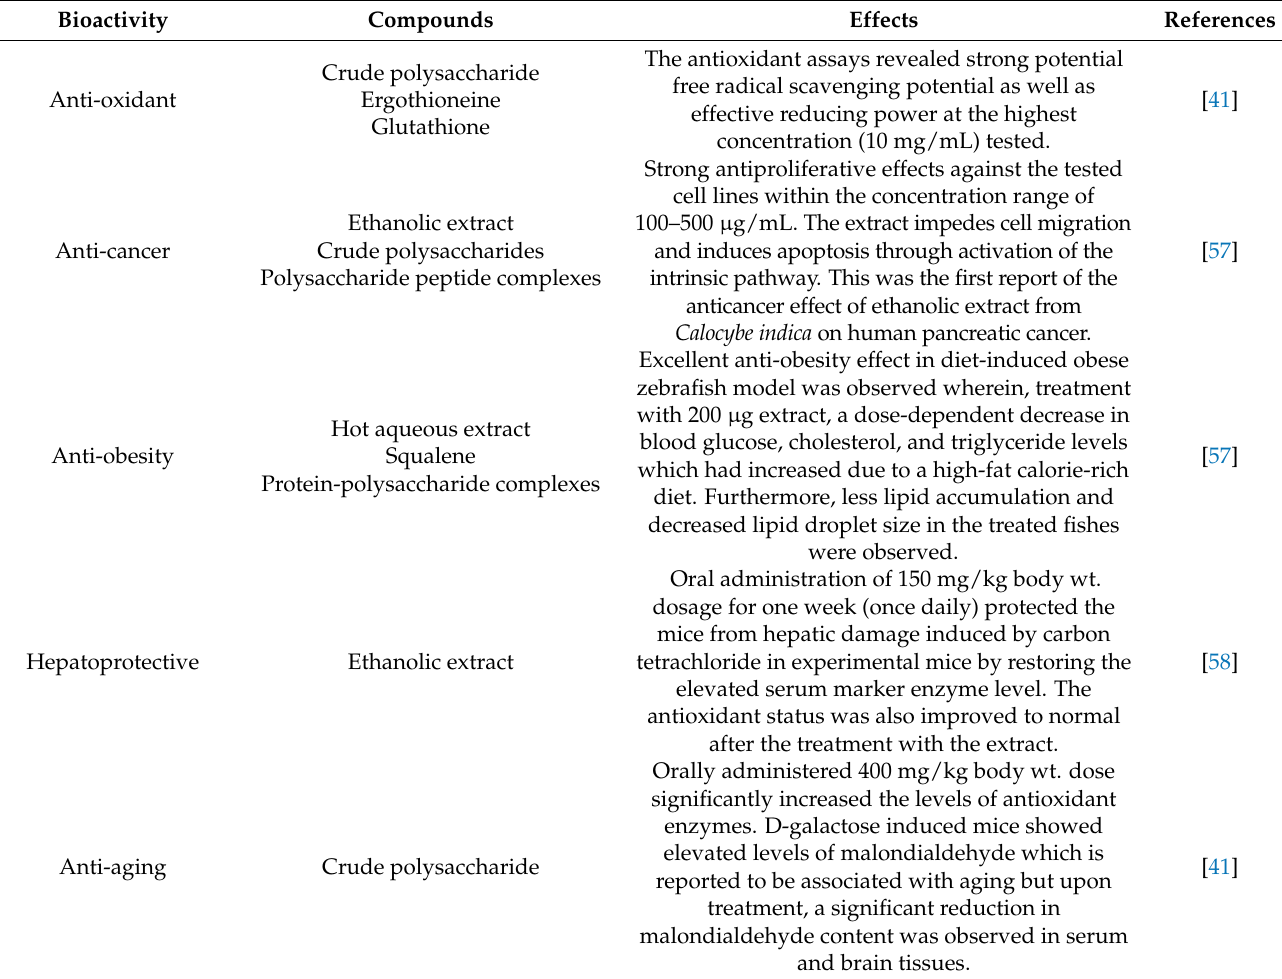
Table 2. The activity of Calocybe indica identified by several extraction methods.